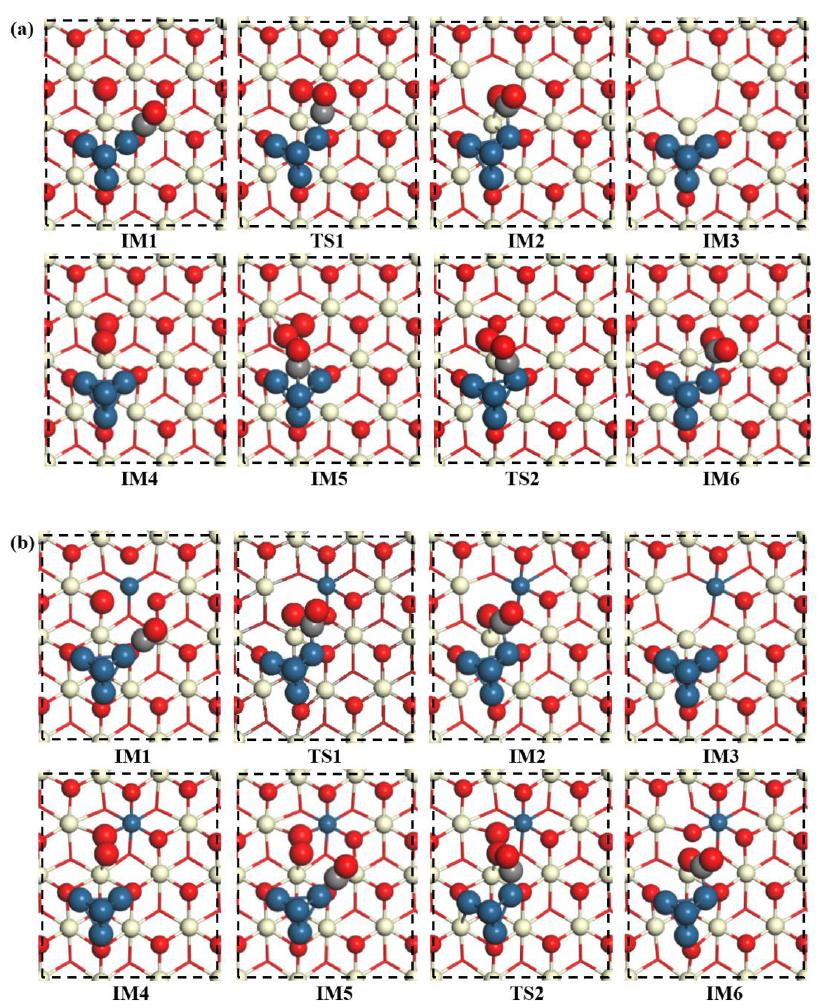
Figure 5. Top view of CO oxidation on the ( a ) Pt 4 /CeO 2 and ( b ) Pt 4 /(Pt − Ce)O 2 surfaces. (IM: intermediate; TS: transition state; FS: final state).